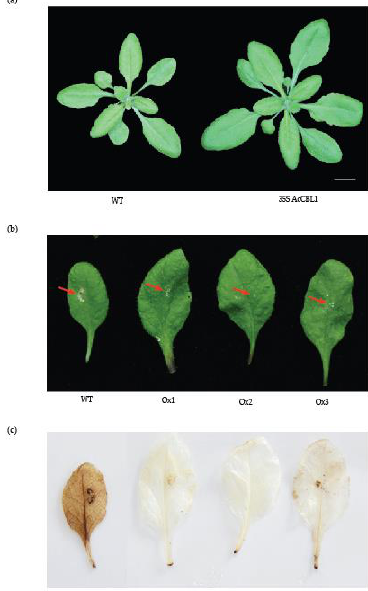
Figure 10. Overexpression of Ac CBL1 results in resistance to biotic stress. ( a ) Morphology of four-week-old wild-type (Col-0) and Ac CBL1 overexpressing plant. ( b ) Damage in leaves by exposure to fungus ( Sclerotinia sclerotiorum ) to mature rosette leaves of wild-type and 3 different lines (Ox1, Ox2, and Ox3) of Ac CBL1 overexpressing plants for 24 h. ( c ) Detection of H 2 O 2 by DAB staining in leaves of wild-type (Col-0) and Ac CBL1 overexpressing lines after 24 h infection of fungus ( Sclerotinia sclerotiorum ). The brown color reflects the reactive oxygen species (ROS) accumulation after the fungus treatment. Scale bar = 1 cm.